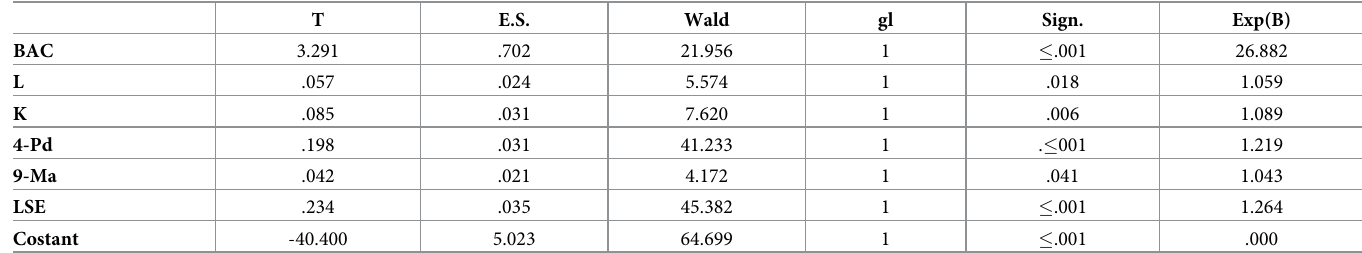
Table 5. Logistic regression model predicting recidivisim.